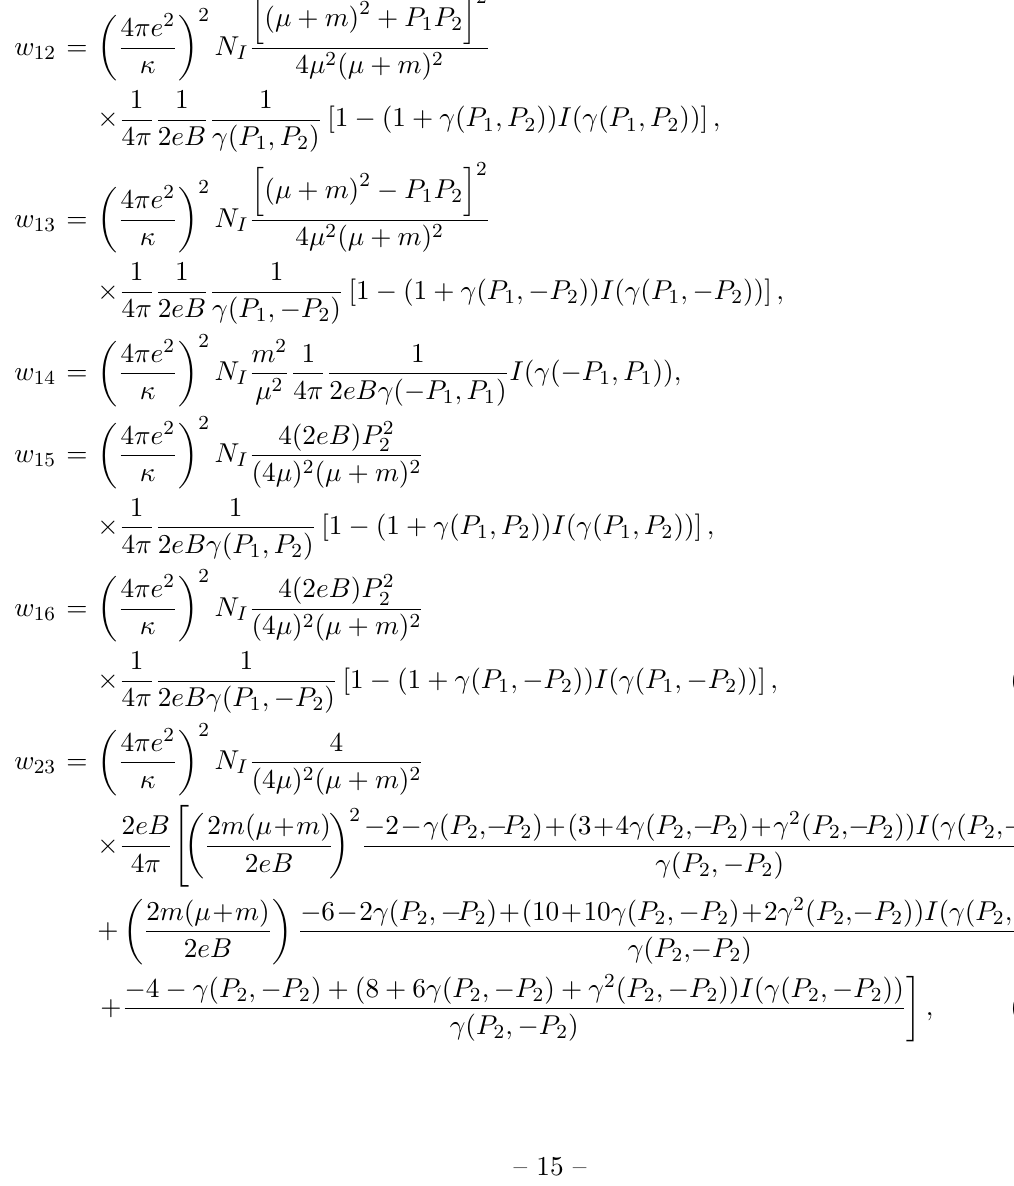
w , w , w , w , w , w . At the Fermi energy (cid:15) ( n; (cid:27) 15 16 23 25 26 56